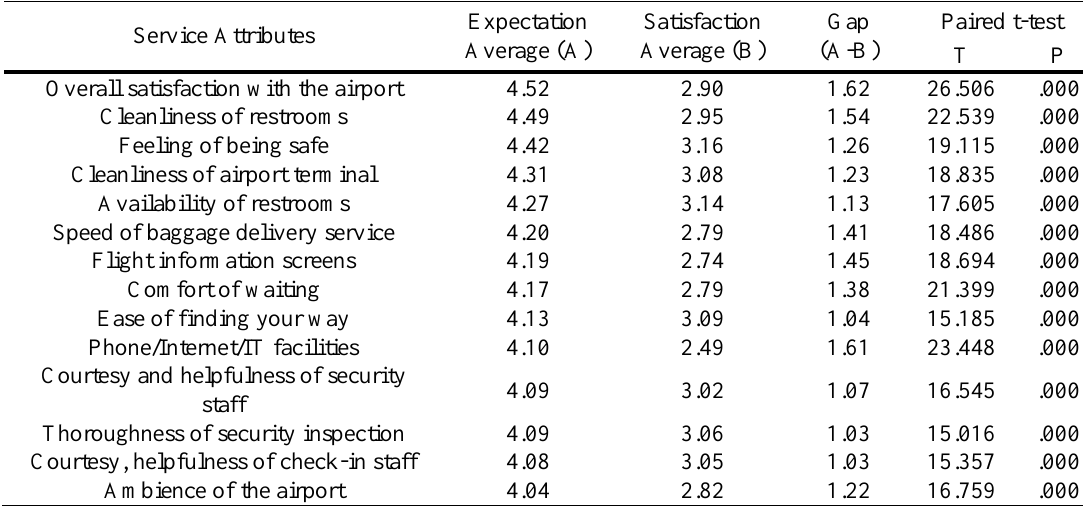
Table 2 . Gap analysis for airport level of